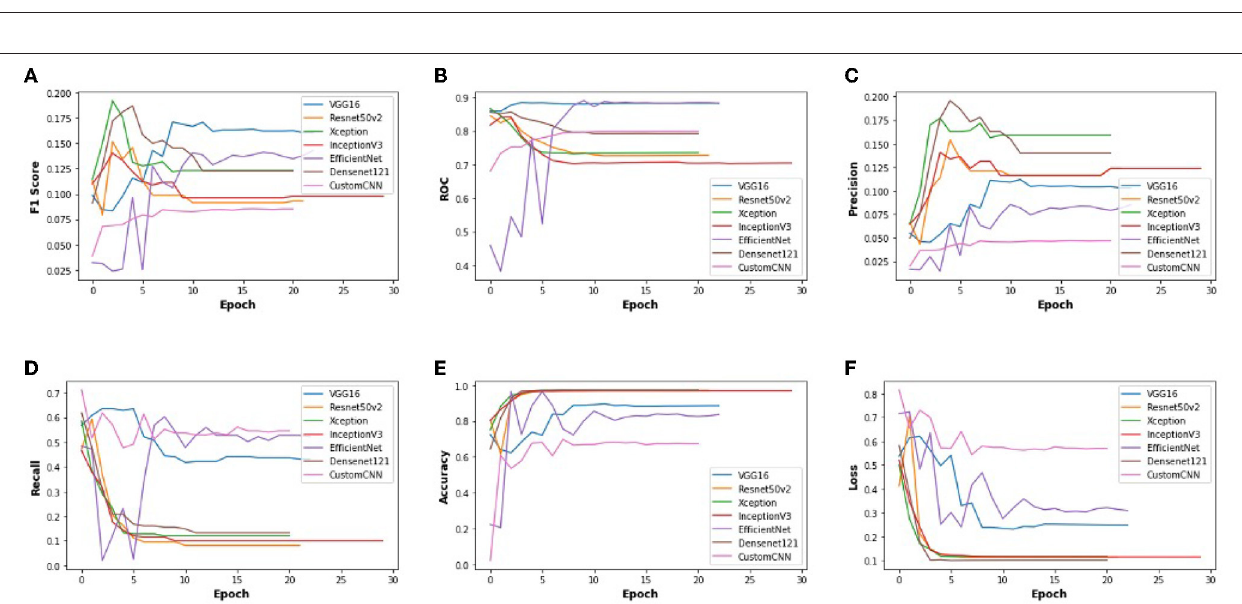
FIGURE 4 | The performance metrics of different architecture of CNN with the variable number of epochs (A) F1 score, (B) ROC, (C) Precision, (D) Recall, (E) Accuracy, and (F) Loss.